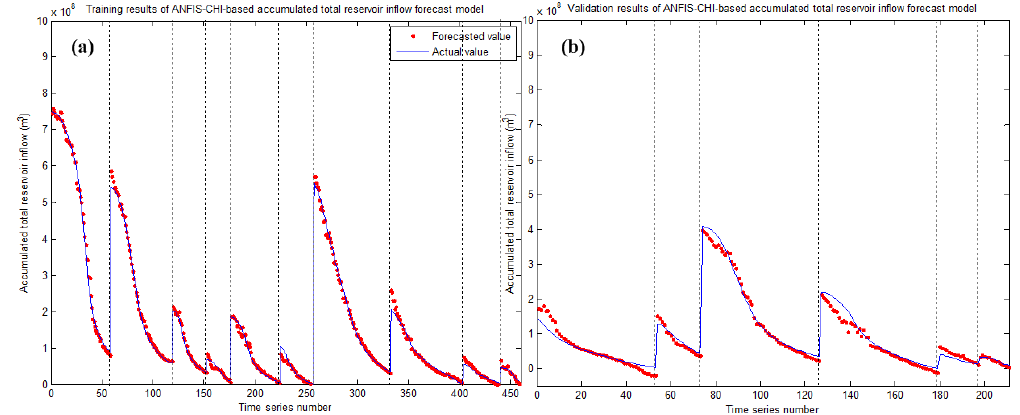
Figure 11. Training and validation results of ANFIS-CHI-based accumulated total reservoir inflow forecast model: ( a ) training stage; ( b ) validation stage.